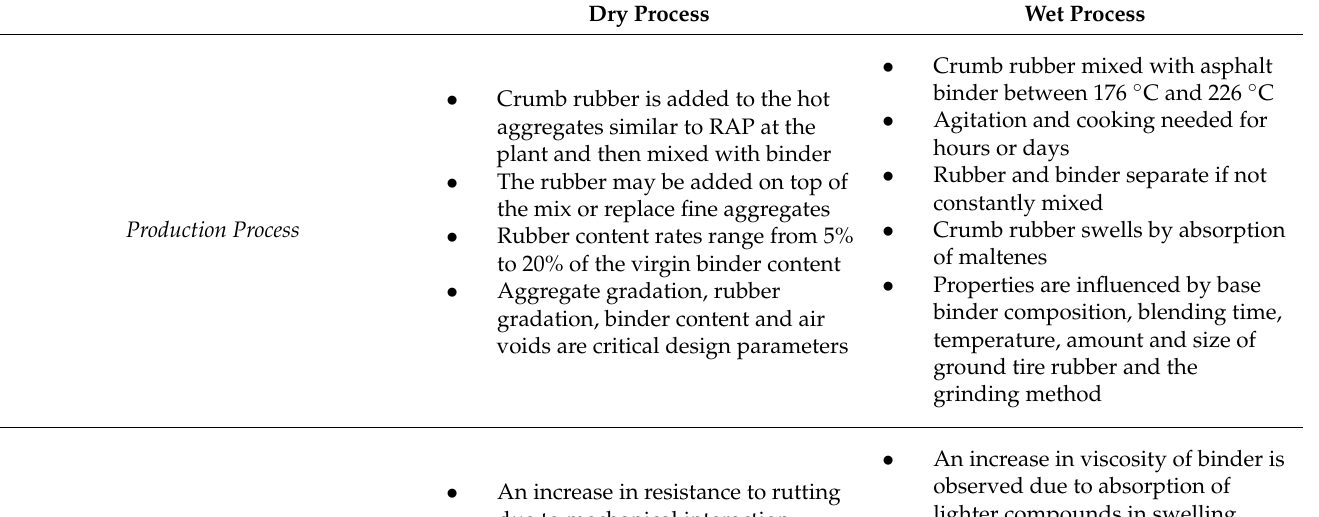
Table 3. Comparison of different production and construction aspects of dry and wet